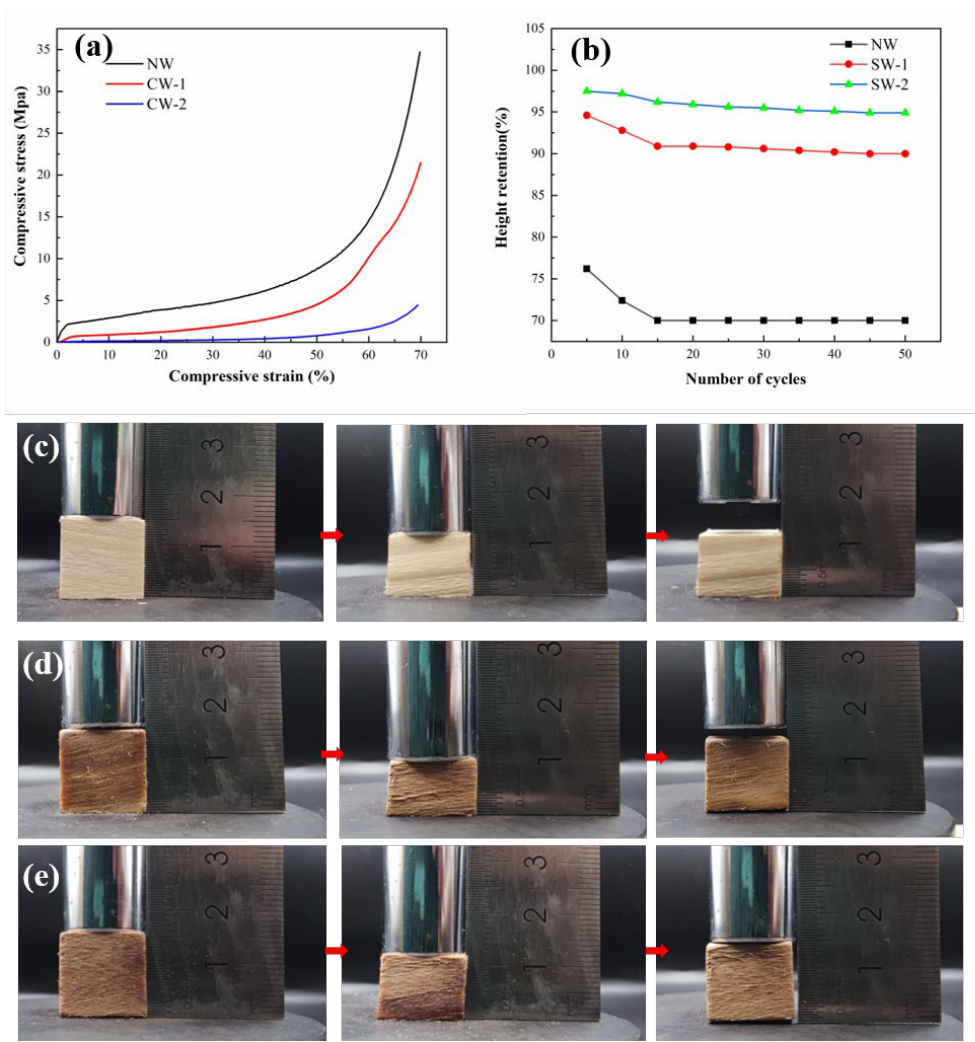
Figure 5. Mechanical properties of NW and CW. ( a ) Stress – strain curves of NW and CW during compression. ( b ) Height retention of NW and CW under cyclic compression with a compression strain of 30%. ( c ) Compression resilience picture of NW. ( d ) Compression resilience picture of CW-1. ( e ) Compression resilience picture of CW-2.